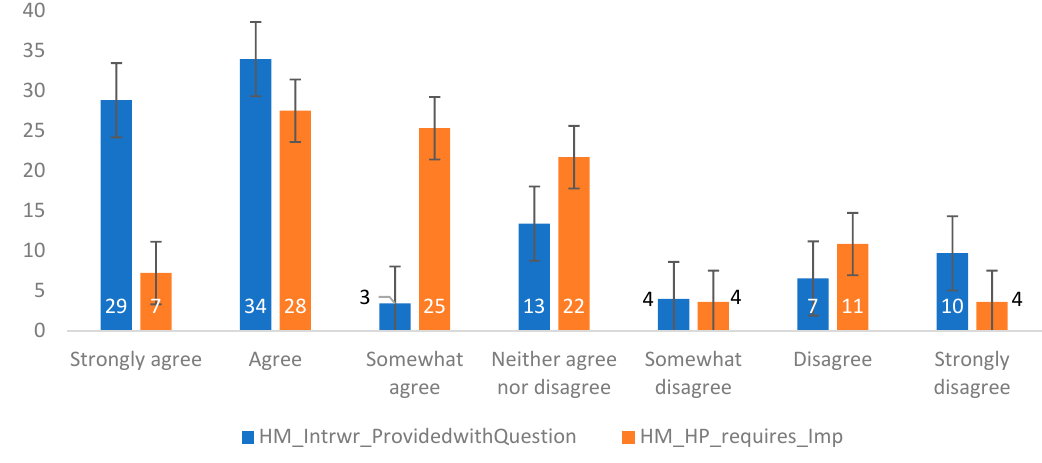
Figure 9. Questions for structured interviews.